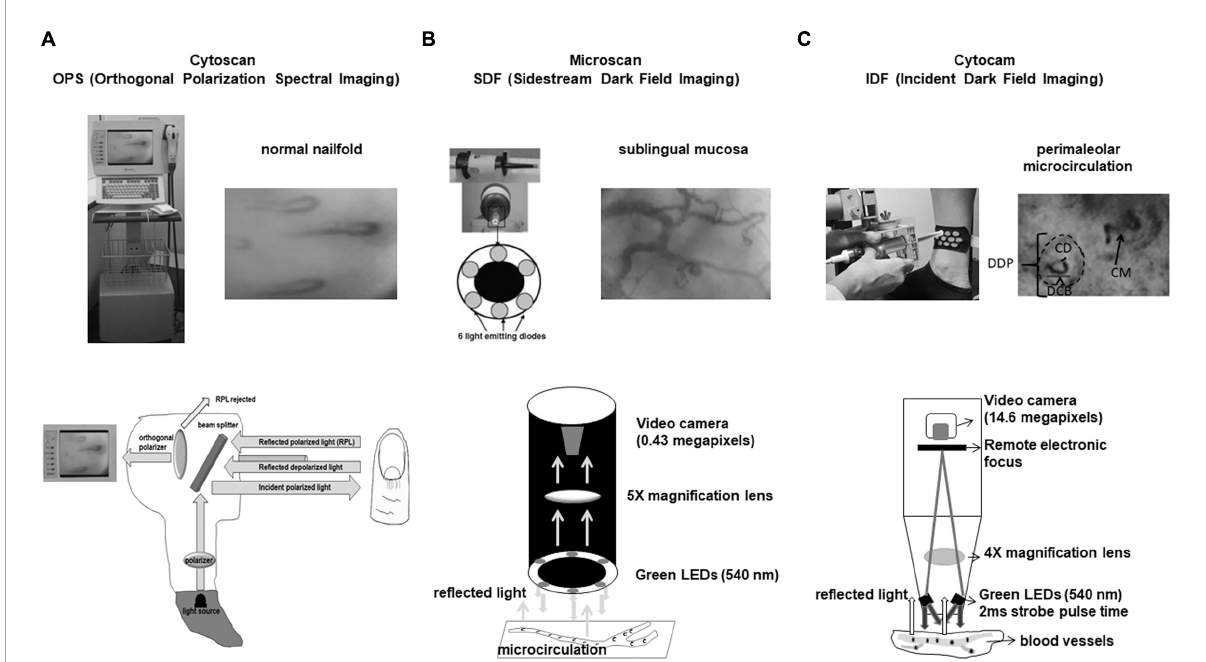
FIGURE2 (A) Cytoscan (OPS technique). Reflected depolarized light from tissue is used to build flowing red blood cells in grayish background. Here one can see the normal nailfold microcirculation. Capillaries have hair pin format. (B) Microscan (SDF technique). Illumination is provided by surrounding central light guide by concentrically placed six light emitting diodes (LEDs) to provide sidestream dark field illumination. Sublingual mucosa microcirculation is shown and we see arterioles, venules, and capillaries very different from nailfold microcirculation where only capillaries can be visualized. (C) Cytocam (IDF technique). IDF associated to optical and better visualization of microcirculation enhanced SDF technology. Cytocam uses incident dark field illumination with high-brightness LEDs with very short illumination pulse time of 2 ms. Perimaleolar microcirculation is shown and the following parameters can be evaluated: DDP, diameter of dermal papilla; DCB, diameter of capillary bulk; CD, capillary diameter; CM, capillary